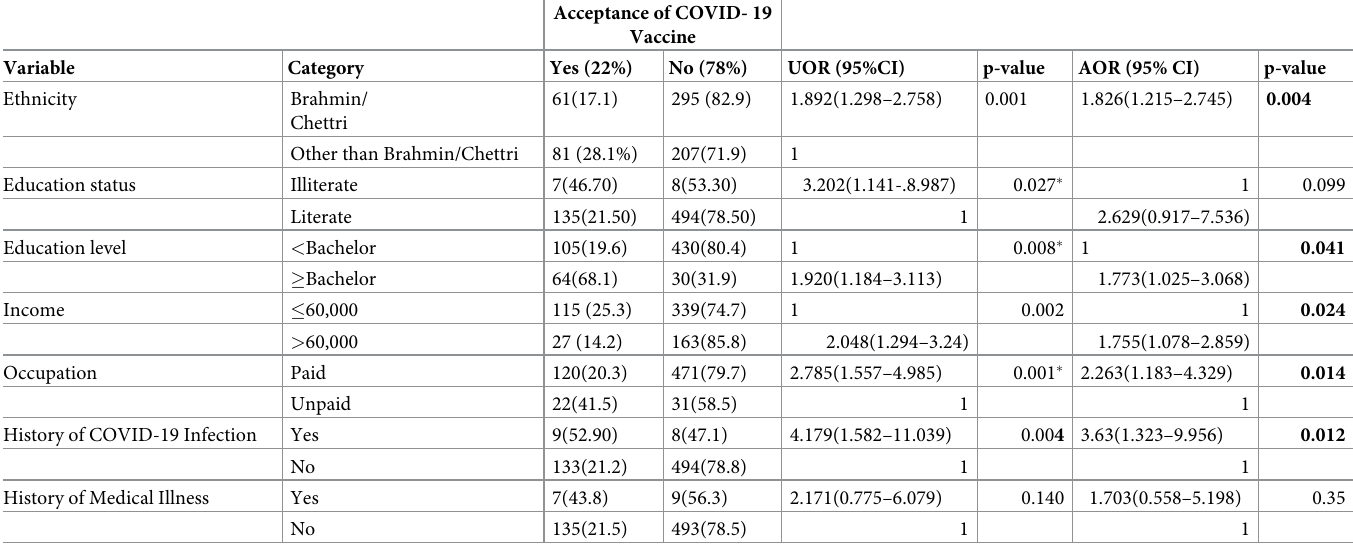
Table 3. Association between acceptance of COVID-19 vaccine and sociodemographic related factors.